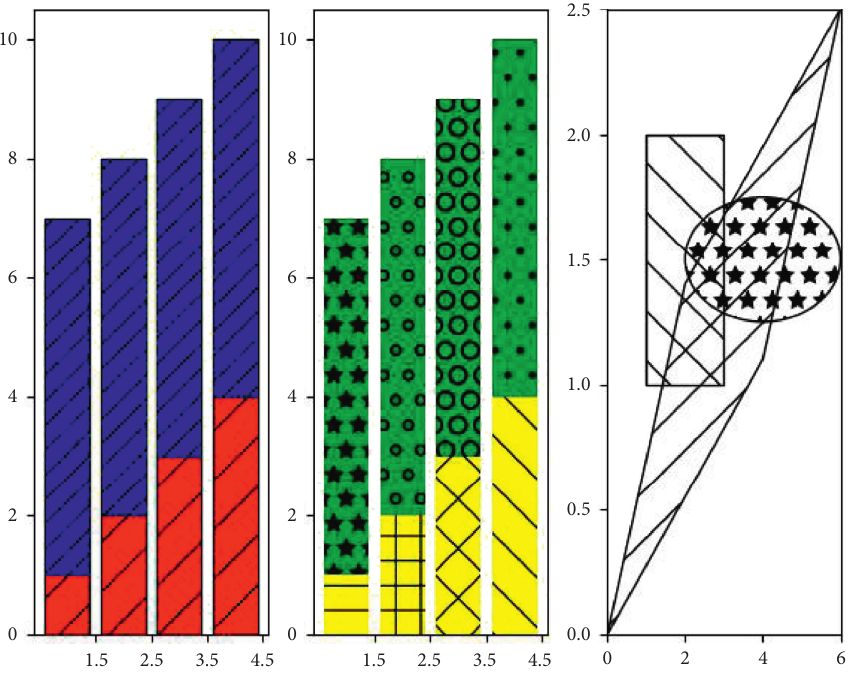
Figure 6: Distribution frequency